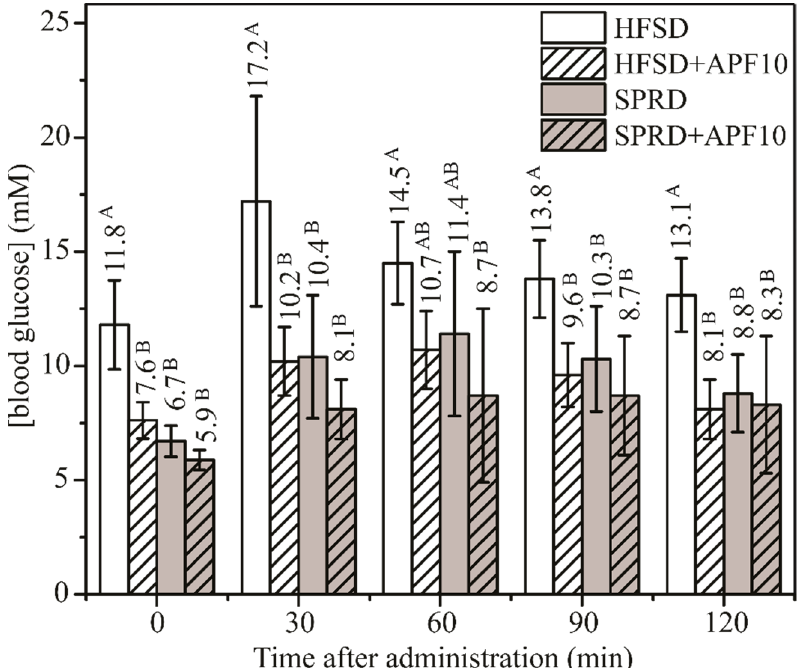
Figure 3. Plasma glucose concentrations in oral glucose tolerance test in mice after 150 days exposure to HFSD and SPRD with and without APF addition. Data were subjected to two-way repeated-measures ANOVA (between-subjects factor: feed treatment ( n = 8); four levels: HFSD, HFSD + APF10, SPRD and SPRD + APF10, degree of freedom was 3, F = 16.6 and p < 0.001; within-subject factor: time; five levels: 0, 30, 60, 90 and 120 min; degree of freedom was 4, F = 14.9 and